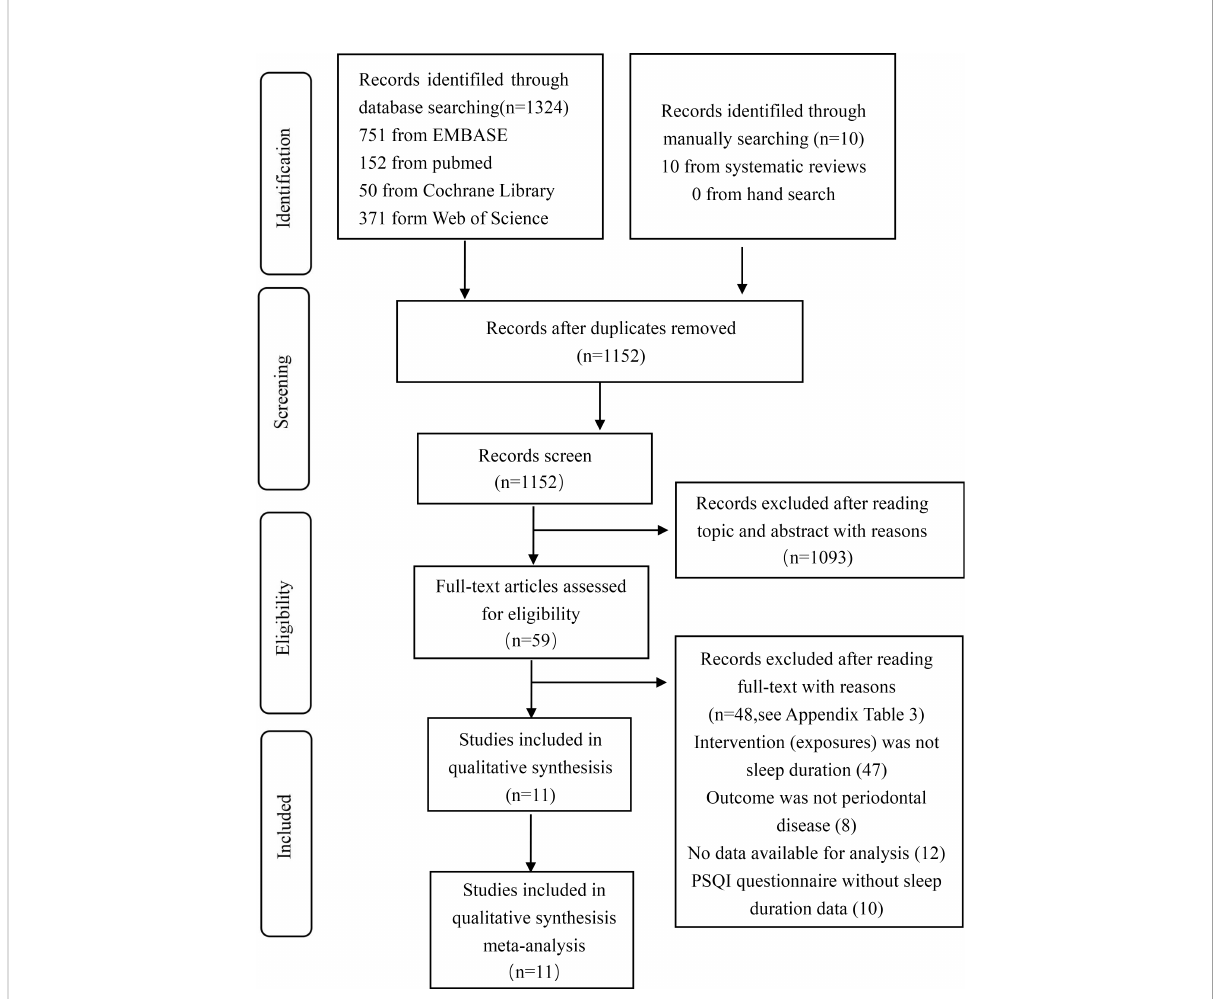
FIGURE 1 The result of search fl